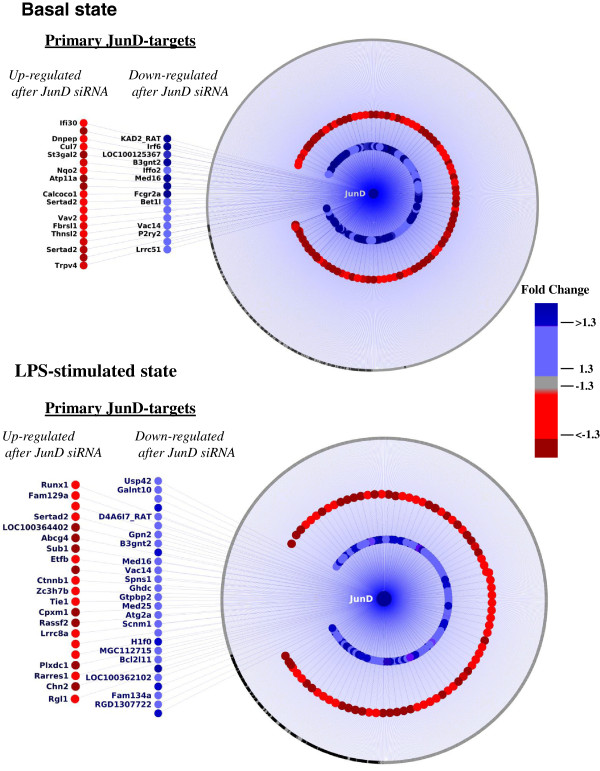
Integrative analysis identifies primary JunD targets in basal and LPS stimulated BMDMs.Jund gene expression patterns in WKY and WKY.LCrgn2 BMDMs over the LPS time course were used for Spearman correlation analysis with the rest of the transcripts on the microarrays (P < 0.001 cut off). The correlated genes were used for building the JunD target gene networks and selected based on i. significant differential expression following Jund siRNA knockdown (both basal and after LPS stimulation FDR< 5%), ii. presence of the JunD ChIP-Seq peak in WKY BMDMs (both basal and after LPS stimulation). The outer ring represents all the transcripts correlating with Jund expression levels (P<0.001) in WKY and WKY.LCrgn2 BMDMs (1445 transcripts, 75%, indicated in grey circles) over the LPS time course. Transcripts associated with a JunD ChIP-Seq peak (within 20kb of TSS or within the gene body) are shown as black circles (232 transcripts, 12%). The transcripts correlating with Jund expression levels and down-regulated following Jund siRNA (basal, upper panel) are shown in blue (125 transcripts, 6.5%); and those up-regulated (basal, upper panel) are shown as red circles (116 transcripts, 6%). Primary JunD targets in basal BMDMs are given with the gene names and show a JunD ChIP-Seq peak (24 transcripts, basal state, upper panel). This analysis was repeated for the LPS-stimulated macrophages taking into account JunD siRNA and ChIP-Seq datasets in LPS stimulated macrophages and identified 36 primary Jund targets (lower panel).